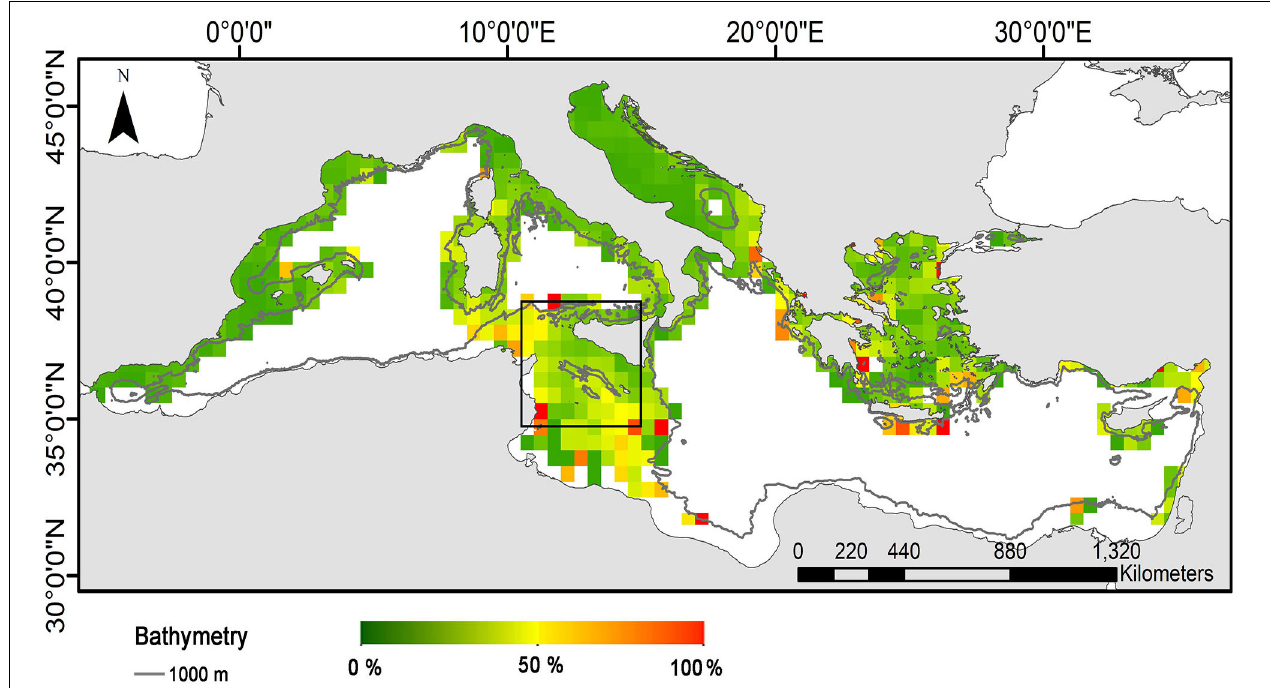
FIGURE 4 | Mean percent values of potential hidden fishing out of total fishing activity